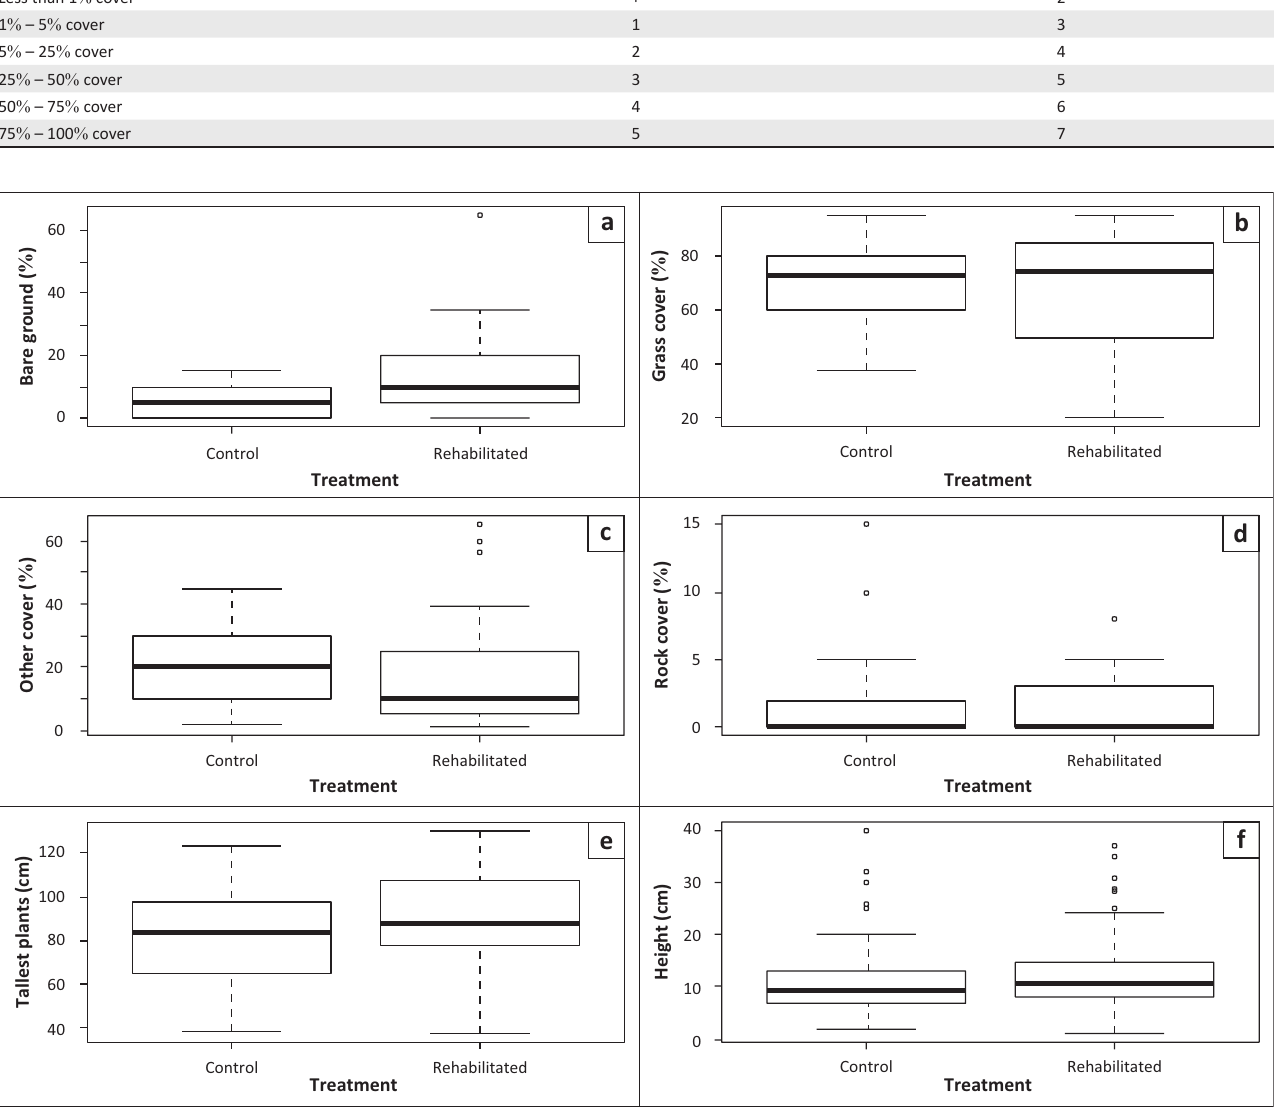
FIGURE 1-A2: Box plots indicating the various vegetation indices recorded in 1 m × 1 m quadrats, (a) percentage bare ground, (b) percentage grass cover, (c) percentage of other cover (forbs, shrubs and herbs), (d) percentage rock cover, (e) height (cm) of the tallest plant in each of the quadrats for each of the sites and (f) height of the biomass recorded from the disk pasture